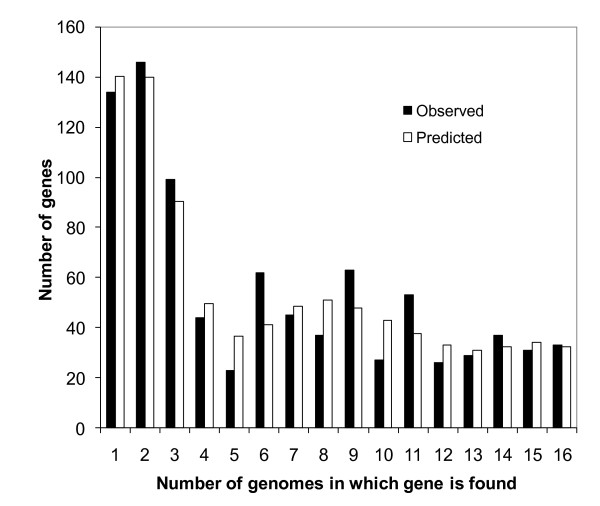
Histogram of observed sample gene frequencies compared to the predicted number using the finite supragenome model. The number of genes for each frequency class was calculated using the results from our revised finite supragenome model (trained on all 17 strains). The observed and predicted number of core genes (2,266) found in all 17 strains agreed exactly; these values are not shown to avoid distortion of the scale of the graph. Distributed genes appear in two or more strains, but not all (from 2 to 16 here).